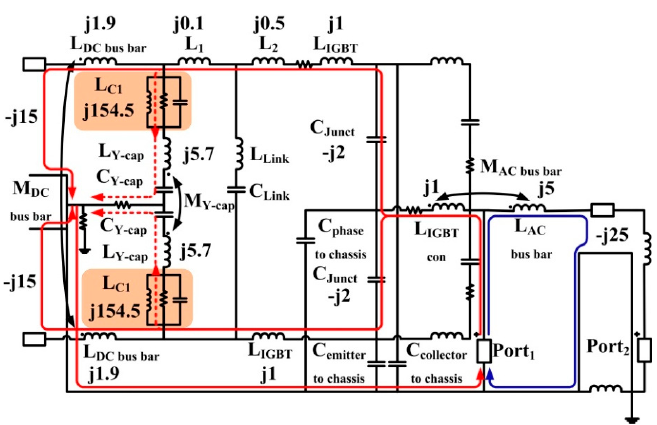
Figure 12. Current ‐ following path at 6 MHz after adding a CM ferrite choke through the Y ‐ caps.